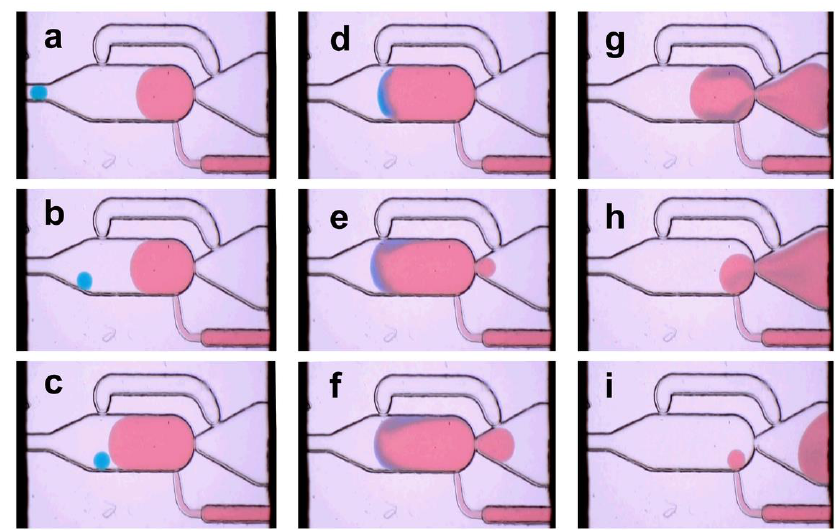
Figure 5. Image series of the single droplet dilution mode (Figure 2B). An initial 40 nL droplet (blue dyed) is delivered into the chamber ( a – b ). The dilution media (red dyed) is feed into the chamber in parallel. The electrocoalescence is permanently on and cause the fusion if the boundaries get in touch ( c – d ). The expanded droplet of about 550 nL blocks the bypass and initiates the release from the chamber, which is forced by the flow of the carrier medium ( e – h ) (frame rate 3 Hz).